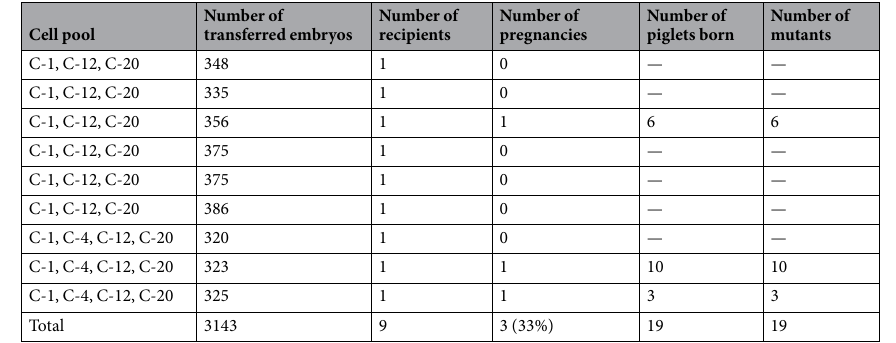
Table 2. Somatic cell nuclear transfer results for the generation of C3 knockout cloned pigs.